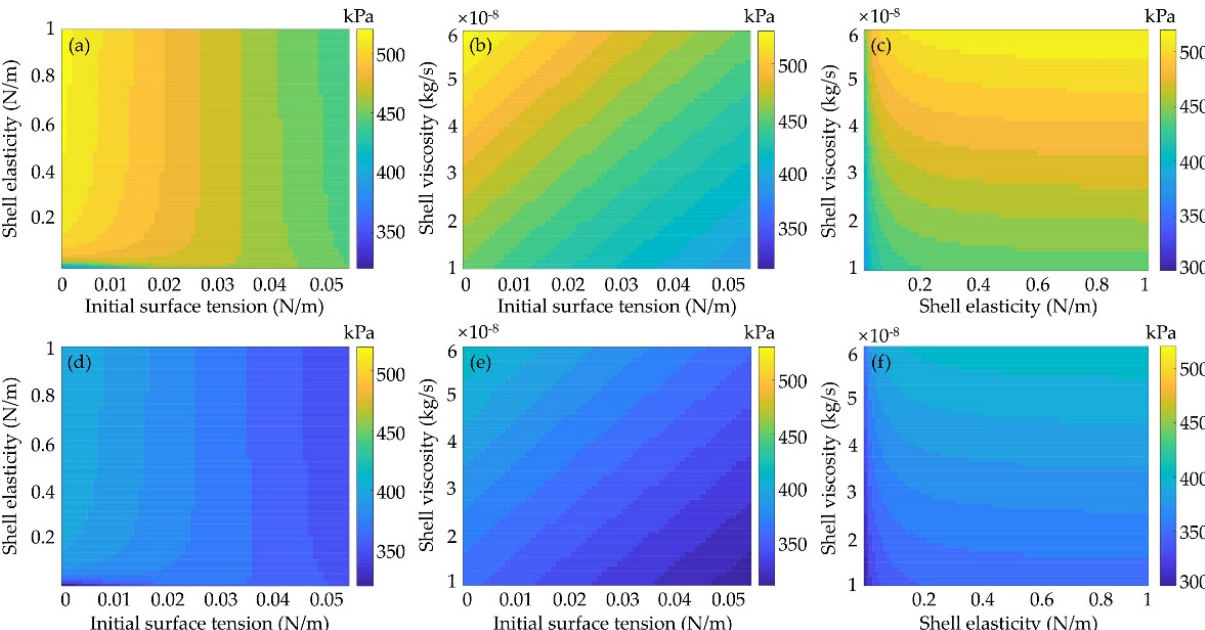
Figure 6. Effects of shell properties on the inertial cavitation threshold of a 1 µ m lipid-coated microbubble ( a – c ) with and ( d – f ) without considering the inter-bubble interactions with a large lipid-coated bubble ( R 20 = 5 µ m). Threshold mapping with ( a , d ) variation of the initial surface tension and the elasticity of shells, ( b , e ) variation of the initial surface tension and the viscosity of shells and ( c , f ) variation of the shell elasticity and the shell viscosity. The inter-bubble distance is 20 µ m.